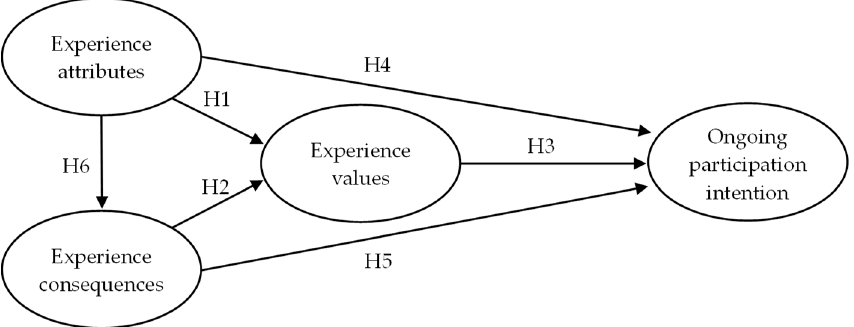
Figure 1. Research framework.